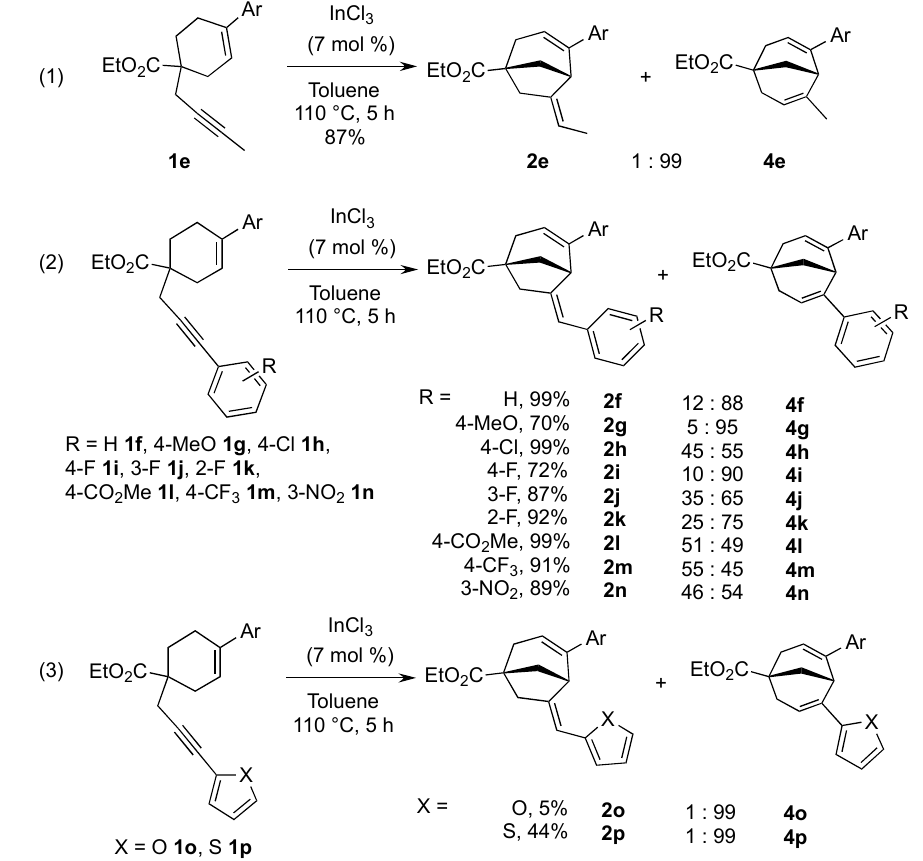
Scheme 4. In-catalyzed cycloisomerization of substituted derivatives 1e – p (Ar = 4-MeOC 6 H 4